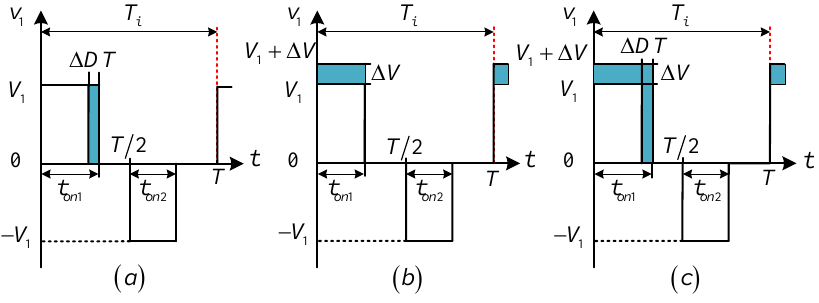
Figure 3. The voltage across the primary winding under positive unbalanced conditions: ( a ) The pulse width imbalance. ( b ) The amplitude unbalance. ( c ) Both pulse width and amplitude are